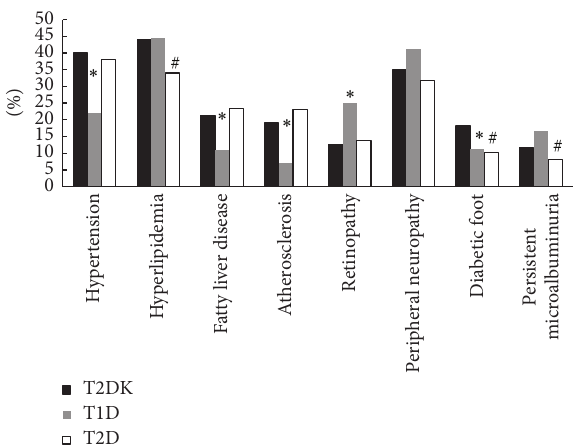
Figure 2: Chronic complications of diabetes. T2DK, type 2 diabetes with ketosis; T1D, type 1 diabetes; T2D, type 2 diabetes. ∗ 𝑃 < 0.05 , T2DK versus T1D; # 𝑃 < 0.05 , T2DK versus